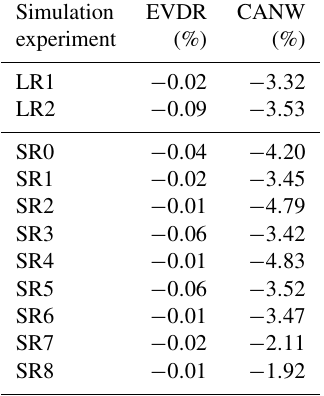
Table 4. Evaporative loss expressed as soil moisture percentage change for the whole irrigated domain in July, due to EVDR, the impact of microphysics process (e.g., droplet evaporation), and CANW, the impact of canopy and leaves interception. Simulation